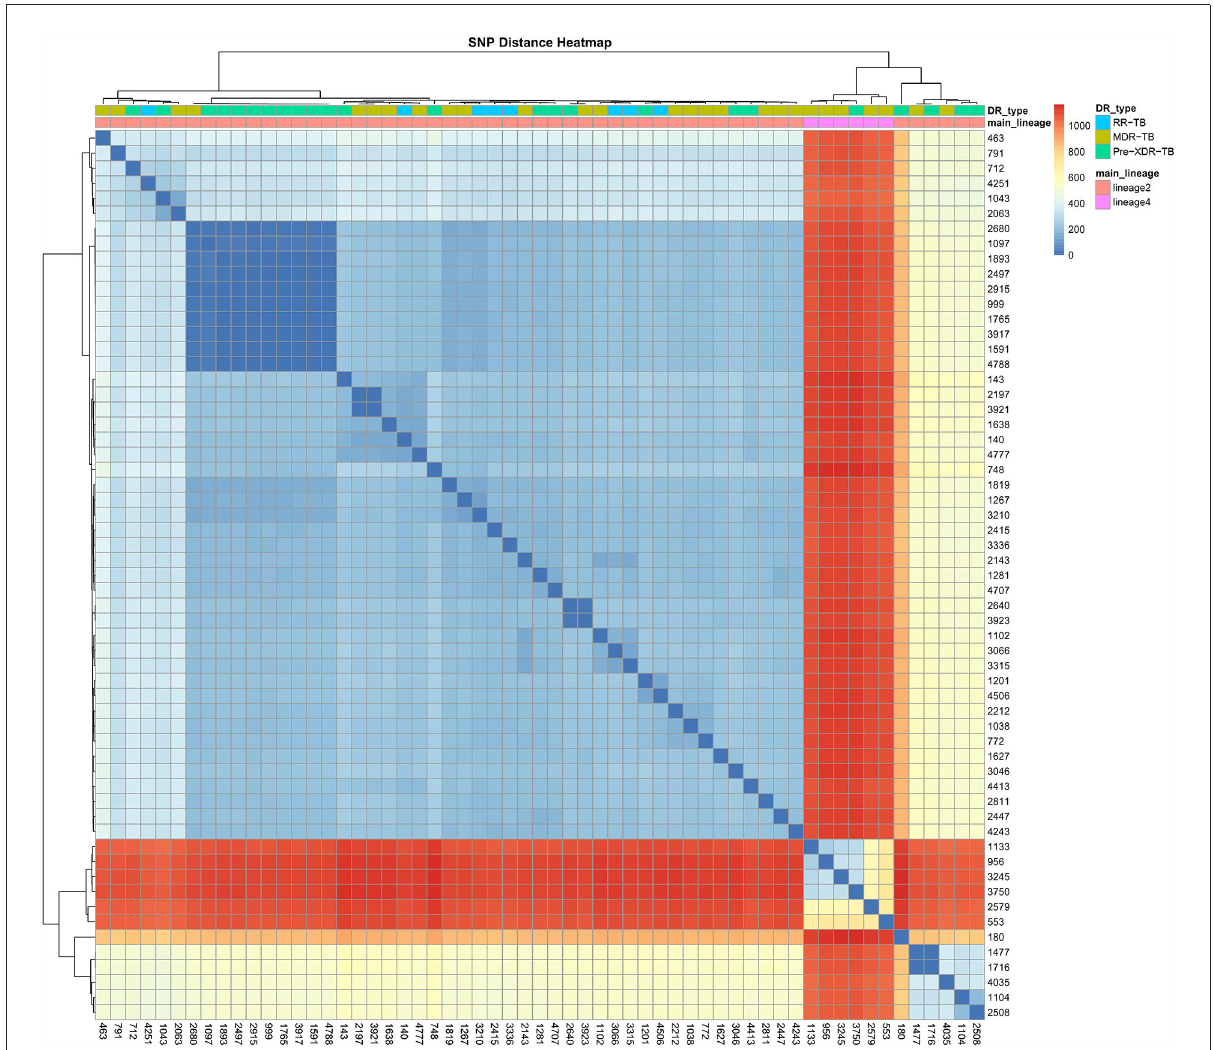
FIGURE2 SNP difference heatmap of the 59 R-R MTB